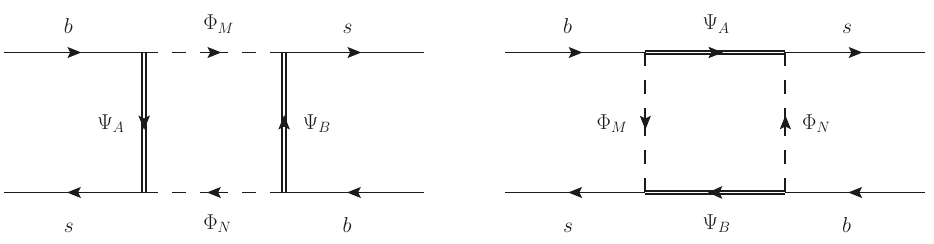
Figure 3 . Box diagrams contributing to B s (cid:0) (cid:22) B s mixing. Both diagrams arise independently